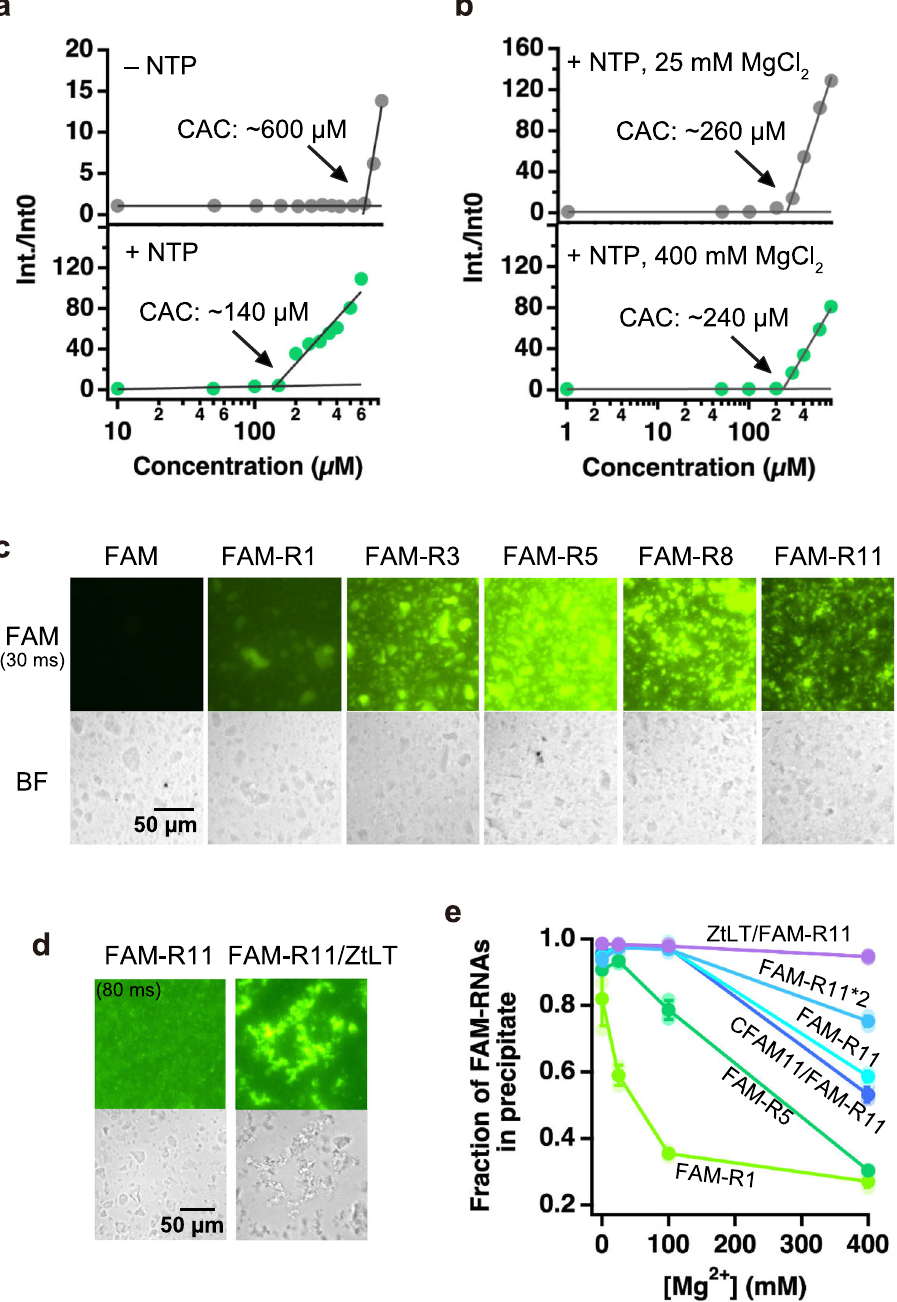
Fig. 2 Aggregates of the P43 peptides. a The CAC of P43 in 0.4% DMSO in the absence or presence of 500 µ M NTPs. b The CAC of P43 in 50 mM Tris • HCl (pH 8.3) buffer containing 500 µ M NTPs, 0.4% DMSO, and 25 mM or 400 mM MgCl 2 . c Microscopic analysis of the P43 aggregates (4 mM, 2% DMSO) mixed with fl uorescently-labeled RNAs (20 µ M FAM-R1 – R11) in 0 mM MgCl 2 . The samples were observed with bright- fi eld and fl uorescence- fi lter setups (FAM, exposure time = 30 ms). d Microscopic analysis of the P43 aggregates (4 mM, 2% DMSO) mixed with fl uorescently-labeled RNAs (0.5 µ M FAM-R11 and Zt LT /FAM-R11) at 0 mM MgCl 2 . The samples were observed with bright- fi eld and fl uorescence- fi lter setups (FAM, exposure time = 80 ms). e The fraction of fl uorescently-labeled RNAs (0.25 µ M) in the precipitations with 800 µ M P43 in 50 mM Tris • HCl (pH 8.3) buffers, containing 0.4% DMSO and 0, 25, 100 or 400 mM MgCl 2 . The samples were separated by centrifugation (13000 rpm, 3 min). Error bars represent S.D. ( N =